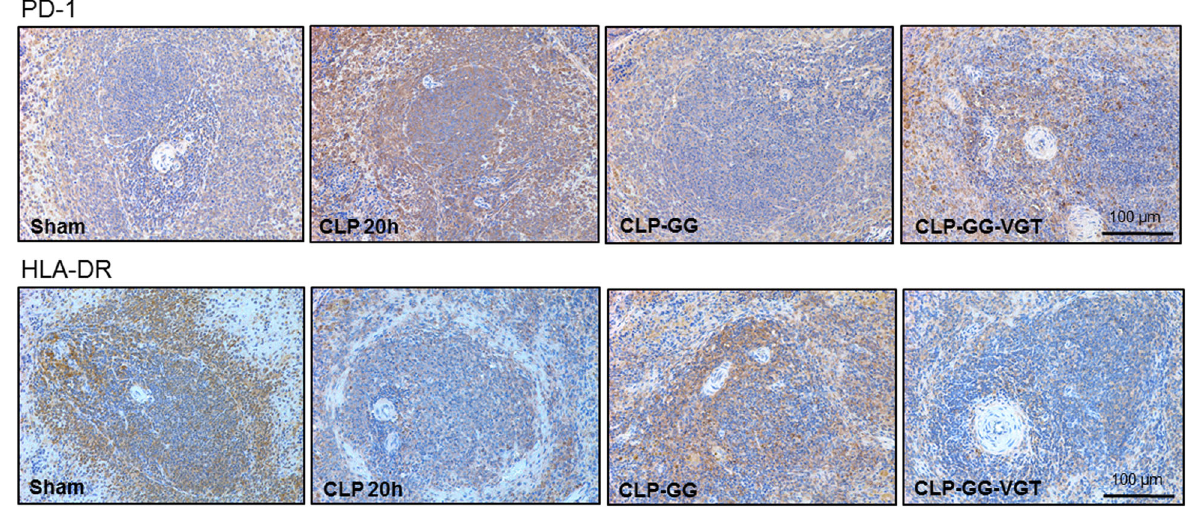
Fig. 5 Ghrelin and GH in combination inhibit PD-1 and increase HLA-DR expression in the spleen of aged rats with sepsis. Rats were subjected to sham or CLP operation and treated with vehicle (normal saline) or GG (ghrelin 80 nmol/kg, GH 50 μ g/kg) at 5 h after CLP. In an additional group of rats, vagotomy was performed at the time of CLP and treated with GG at 5 h after CLP. Spleens were harvested at 20 h after CLP. The expression of PD-1 and HLA-DR in the spleen were evaluated by immunohistochemical staining. The representative images are shown. Each group contains n = 4 spleens from 4 mice. Original magnification of images is 200